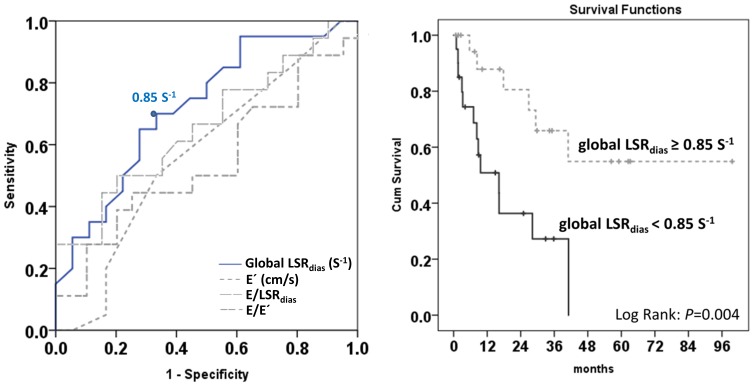
The receiver operating characteristic (ROC) analysis of global early diastolic strain rate (LSRdias) for predicting mortality (left) and cumulative survival stratified by the optimal cut-off value for global LSRdias (right).Global LSRdias serves as the best marker for predicting mortality in cardiac amyloidosis patients with preserved ejection fraction (area under of ROC curve: 0.72 (0.56–0.89), P = 0.019). CA Patients with global LSRdias <0.85 S−1 suggests about 4-fold increase of all-cause mortality than those with preserved global LSRdias value.